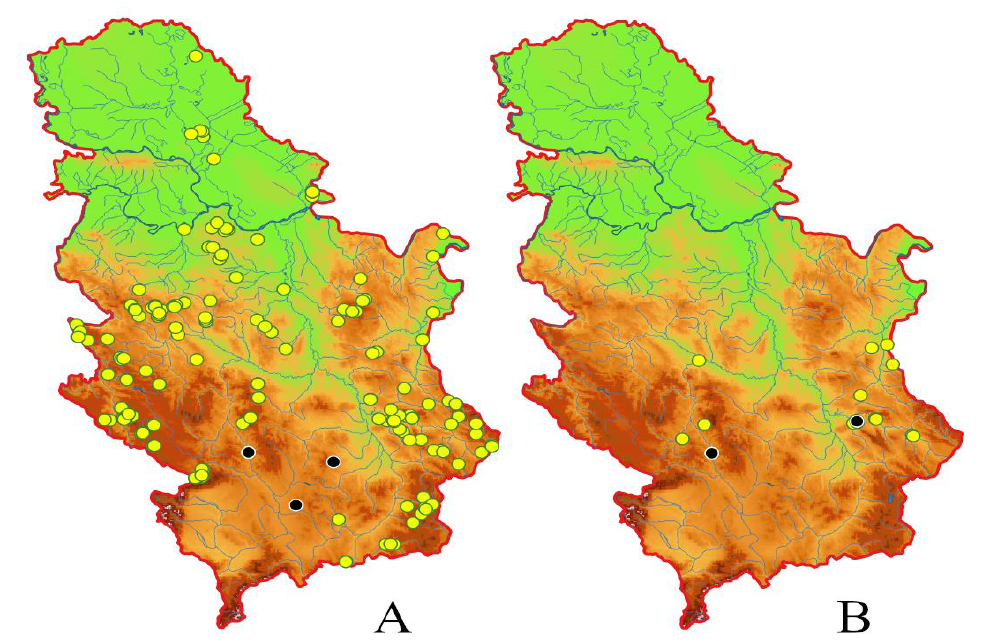
Figure 2. Maps of distribution in Serbia: A − Libelloides macaronius (Scopoli, 1763); B − L. lacteus ( Brullé, 1832). (Yellow − data collected by authors and citizen science, black − published